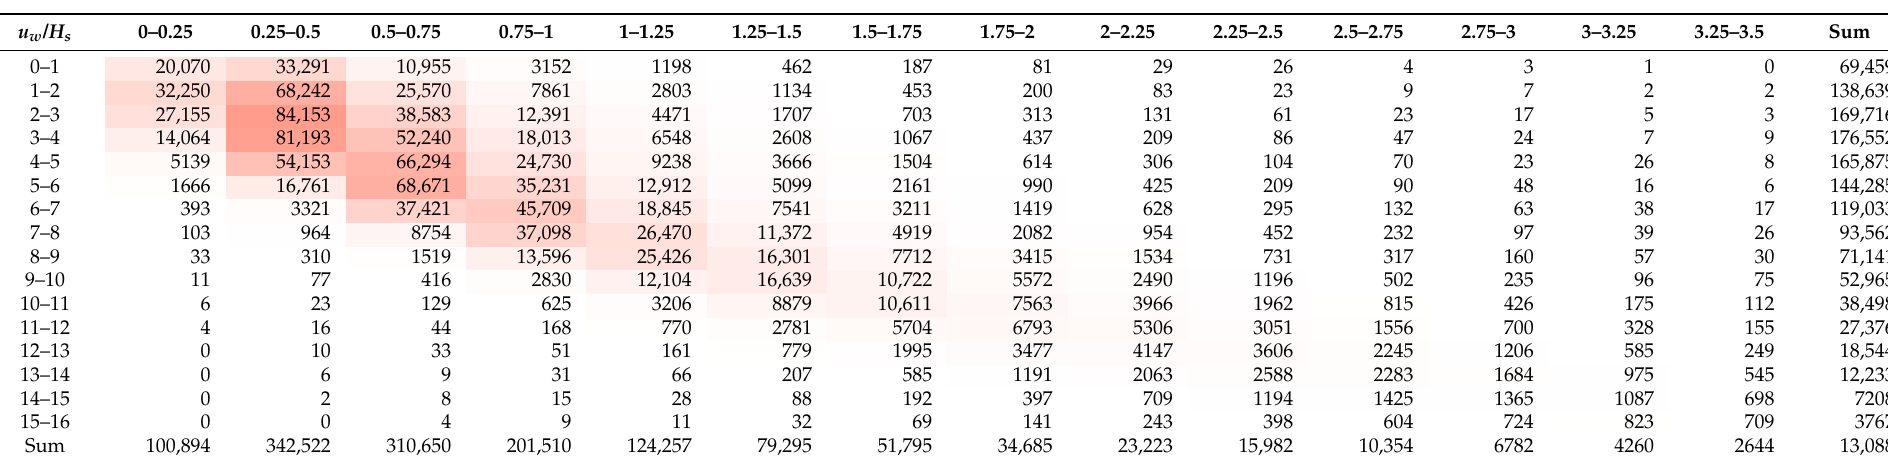
Table 2. Wind speed—significant wave height occurrence—entire Adriatic, Sept 1992–Jan